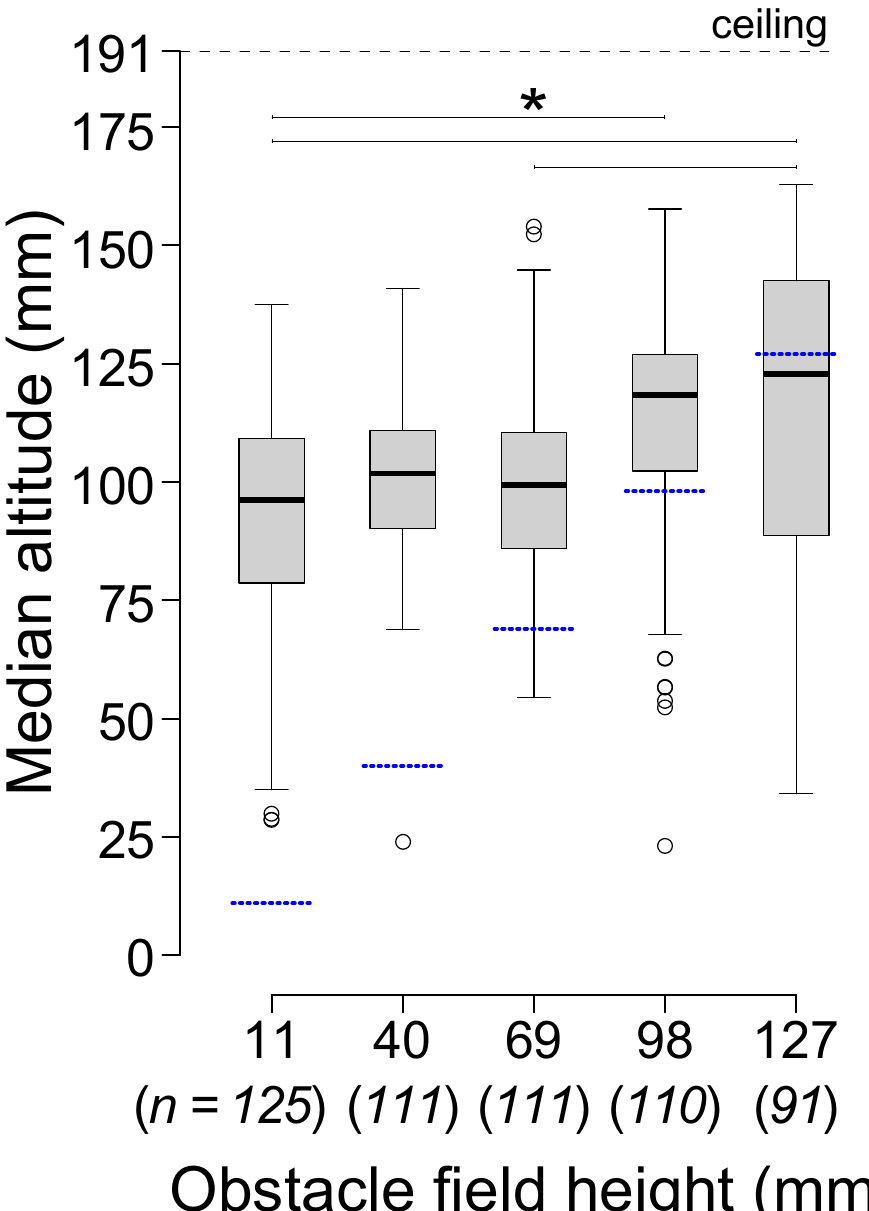
Fig 2. Median altitude of bees transiting obstacle fields. Dashed blue lines in indicate the obstacle field height relative to the flight altitude. Lines with asterisks indicate statistically different groups based on a linear mixed-effect model with Tukey post hoc comparisons ( � P < 0.05). Italicized numbers below the x-axis labels show the sample size (number of flights) for each obstacle field height. differences between the control (shortest) and two highest obstacle heights: median altitude increased by 22.2 mm (23%) from the 11-mm obstacle fields to the 98-mm obstacle fields (df = 53, t-ratio = -3.634, P = 0.006), and increased 26.6 mm (28%) from the 11-mm obstacle fields to the 127-mm obstacle fields (df = 53, t-ratio = -3.881, P < 0.005) (Fig 2). Flight direc- tion had a moderate effect on median altitude (F = 4.447, P = 0.036), but there were no (1,475)